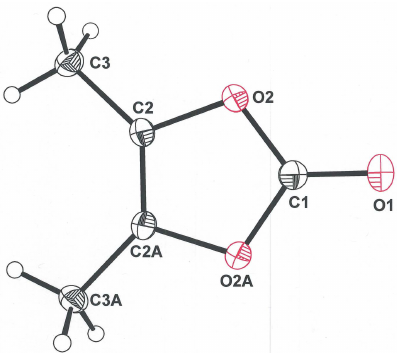
Figure 3 Cell packing diagram of 1 with a view along the b axis of the cell. Displacement ellipsoids are drawn at the 50% level, and all H atoms are omitted for clarity.